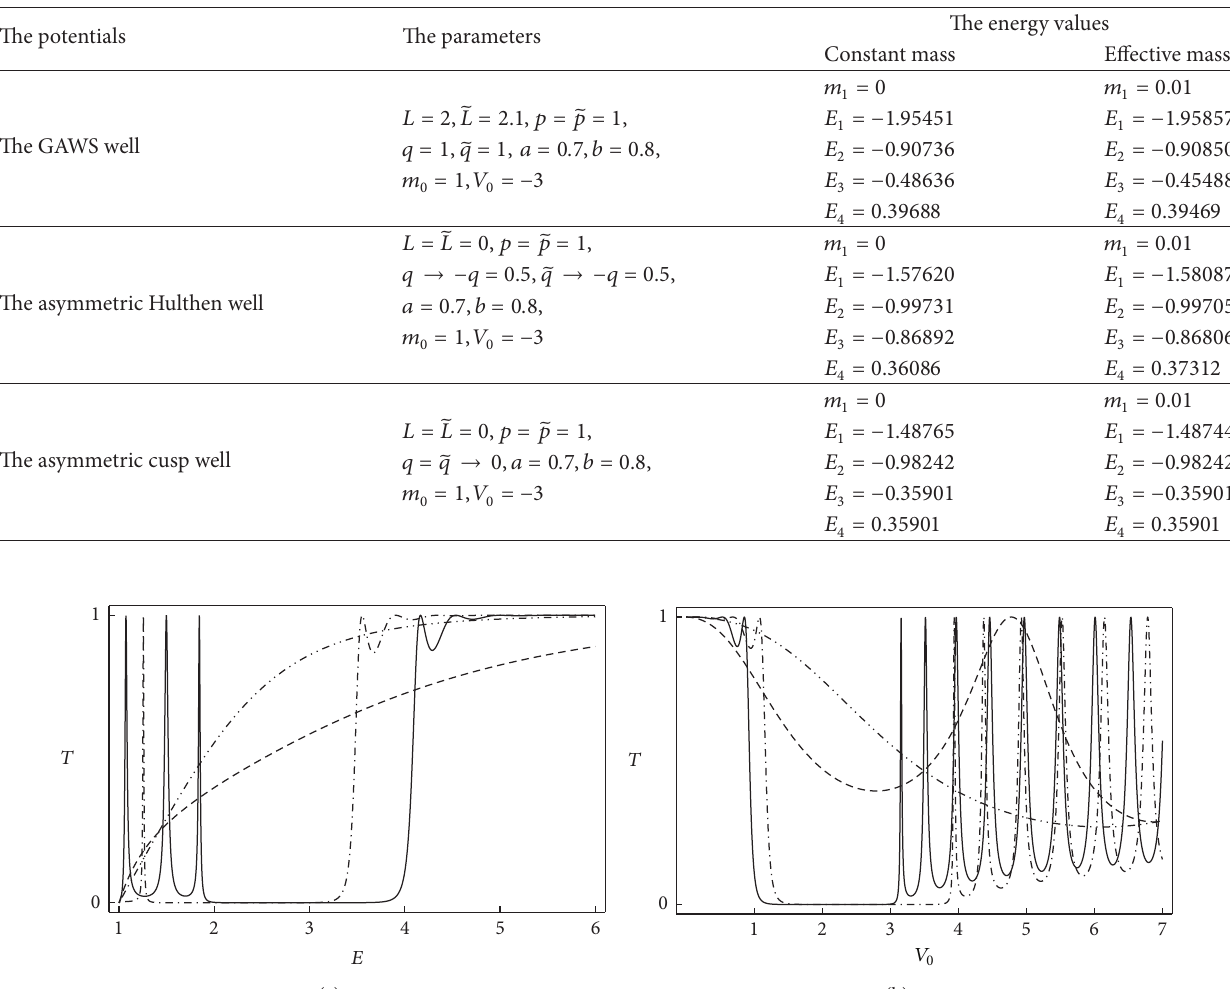
Table 4: The numerical energy values (in atomic units: fm −1 ) for asymmetric wells.